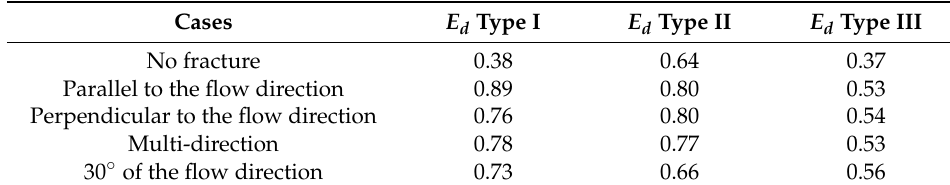
Table 4. The influence of fracture direction on the oil displacement efficiency.